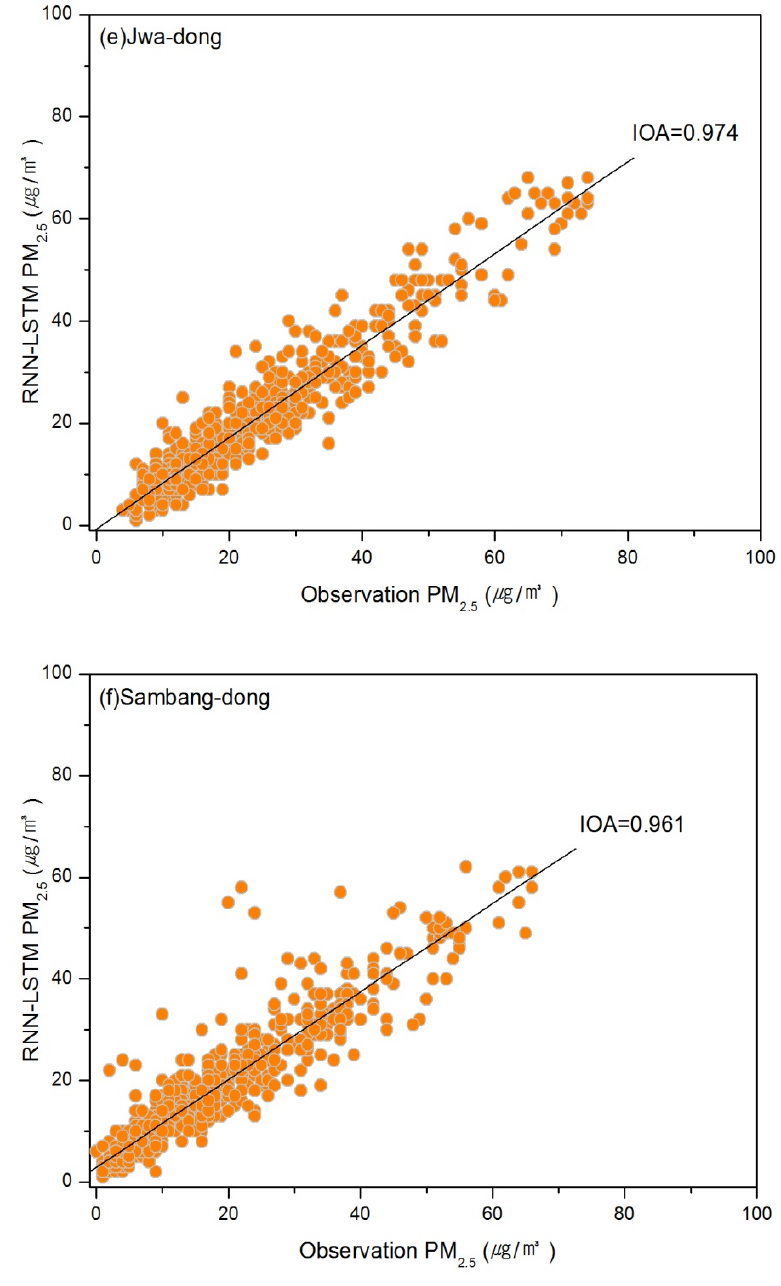
Figure 8. Scatter plot by site (optimal prediction result by RNN-LSTM). ( a ) North Port, ( b ) New Port, ( c ) Yongsu-ri, ( d ) Myeongseo-dong, ( e ) Jwa-dong, ( f ) Sambang-dong.